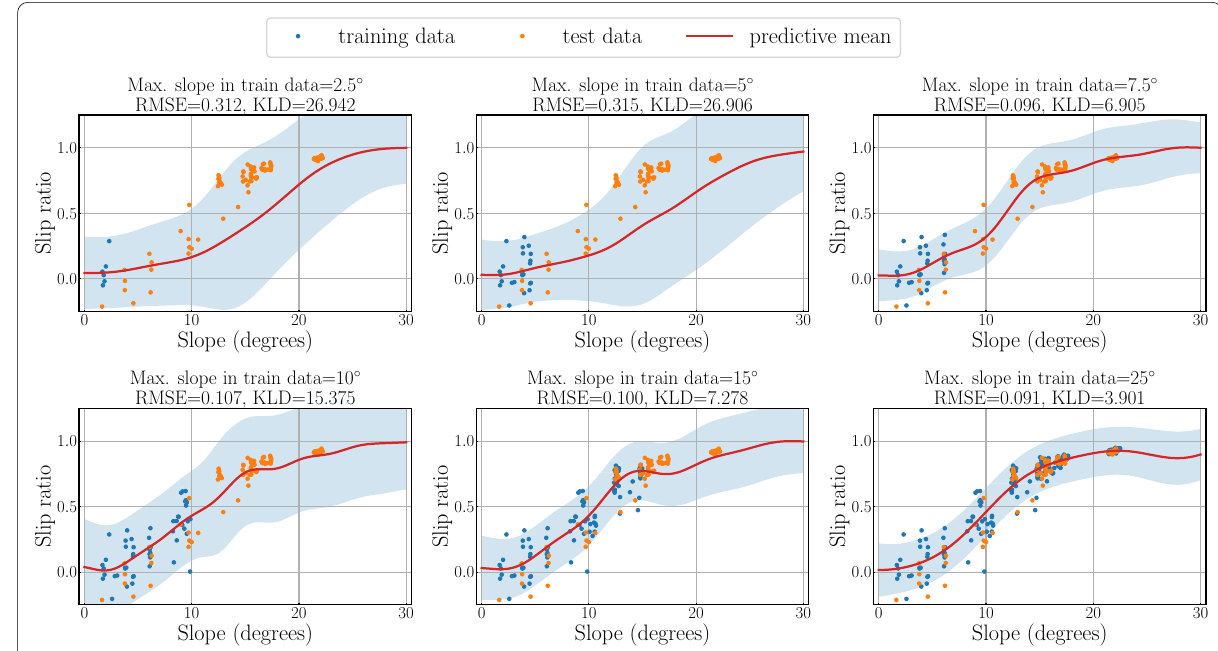
Fig. 10 Models trained on different target training data in Evaluation 3. Slip-slope models learned based on the proposed method are shown for a series of increased target training datasets with increased slope steepness. By using additional target training data, the proposed method could rapidly improve the model distribution with a tighter confidence interval. Results for the rough sand surface class are presented. Note that the shape of the model trained on the data up to 5 ◦ (upper center) is slightly different from that shown in Fig. 8e because the source domains used for training are not the same